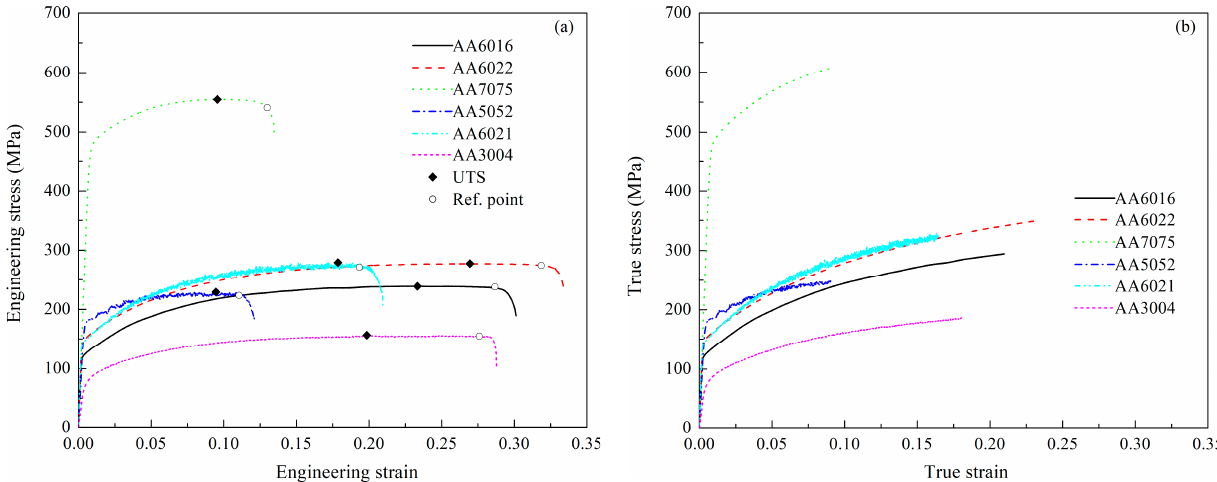
Figure 4. Stress-strain data obtained from uniaxial tensile tests for six aluminum alloy sheets. ( a ) Engineering stress-strain curves. ( b ) True stress-strain curves.